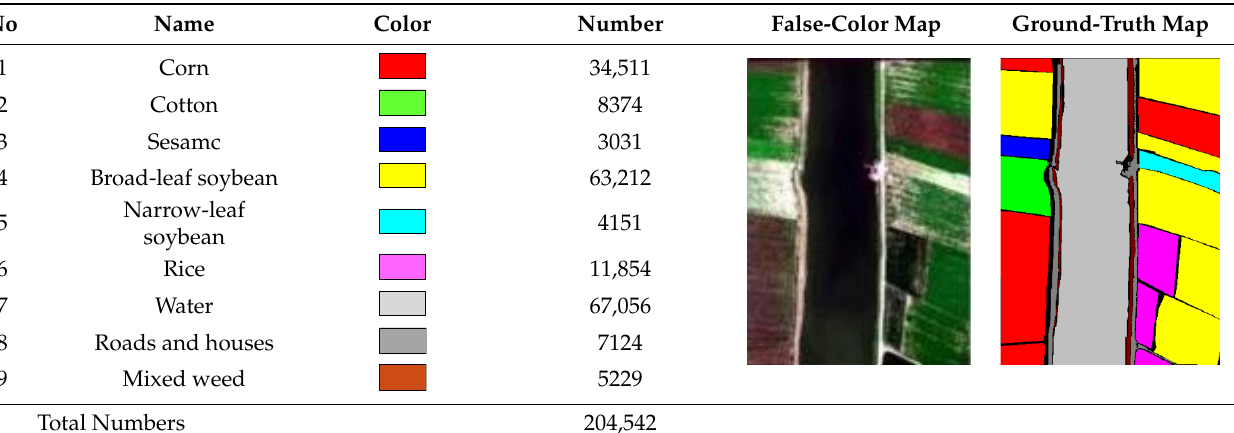
Table 1. Salinas Dataset Labeled Sample Counts.